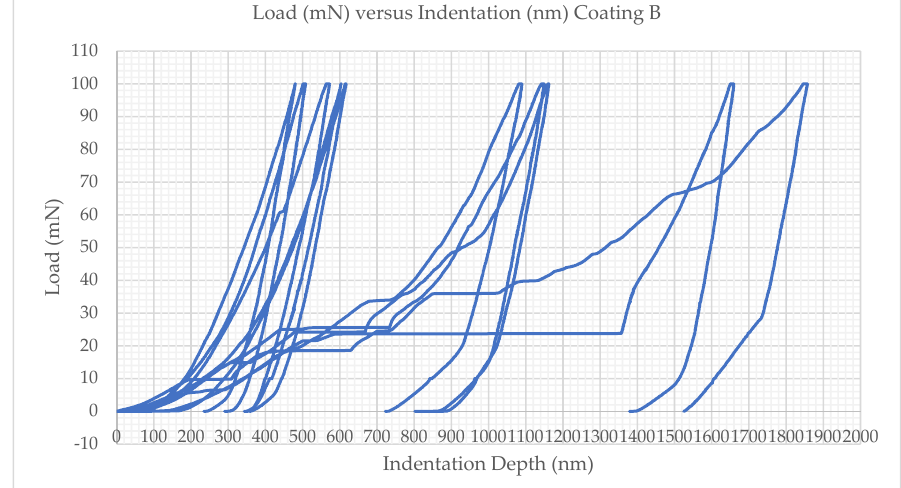
Figure A2. Nanoindentation test results for Coating B.